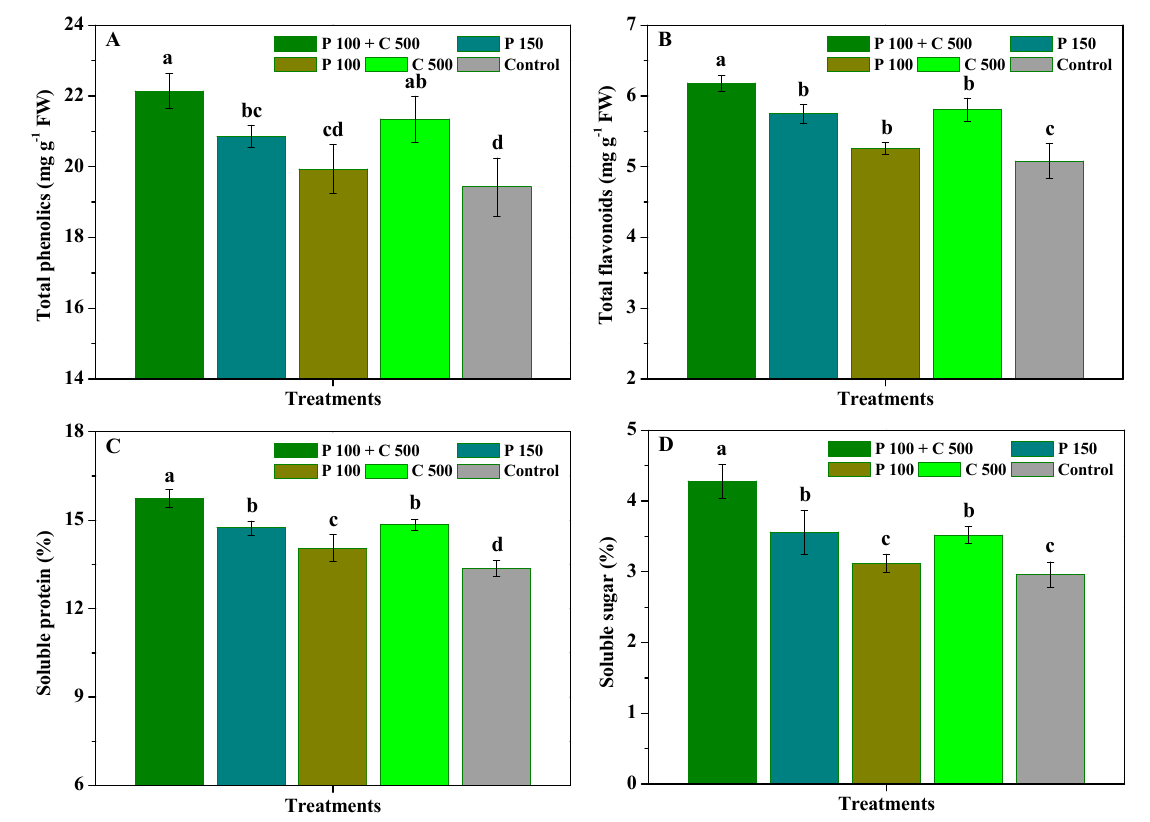
Figure 2. The influence of pyraclostrobin and chitosan on the total phenolics ( A ), total flavonoids ( B ), soluble protein ( C ), and soluble sugar ( D ) contents of R. roxburghii leaves. Error bars indicate the SD of the three replicates. Small letters represent significant differences on a 5% ( p < 0.05) level. The influence of pyraclostrobin and chitosan on the Pro, MDA, SOD and PPO activities of R. roxburghii leaves is shown in Figure 3. Compared with the control, P 100 + C 500, P 150, and C 500 significantly ( p < 0.05) increased the Pro content, SOD and PPO activities of R. roxburghii leaves and reduced their MDA content, while P 100 could only significantly ( p < 0.05) promote their SOD activity and reduce their MDA content. Furthermore, the Pro content, SOD and PPO activities of R. roxburghii leaves treated with P 100 + C 500 significantly ( p < 0.05) exceeded those of P 150, P 100, and C 500, and their MDA content was significantly ( p < 0.05) lower than that of P 150, P 100, and C 500. Meanwhile, the Pro content, MDA content, SOD and PPO activities of R. roxburghii leaves also showed no significant ( p < 0.05) differences in the P 150 and C 500 treatments, but those of C 500 were slightly higher than those of P 150. These results further indicate that chitosan used to- gether with pyraclostrobin could effectively enhance the Pro content, SOD and PPO ac- tivities of R. roxburghii leaves and reduce their MDA content, reliably improving the re- sistance of R. roxburghii to powdery mildew.